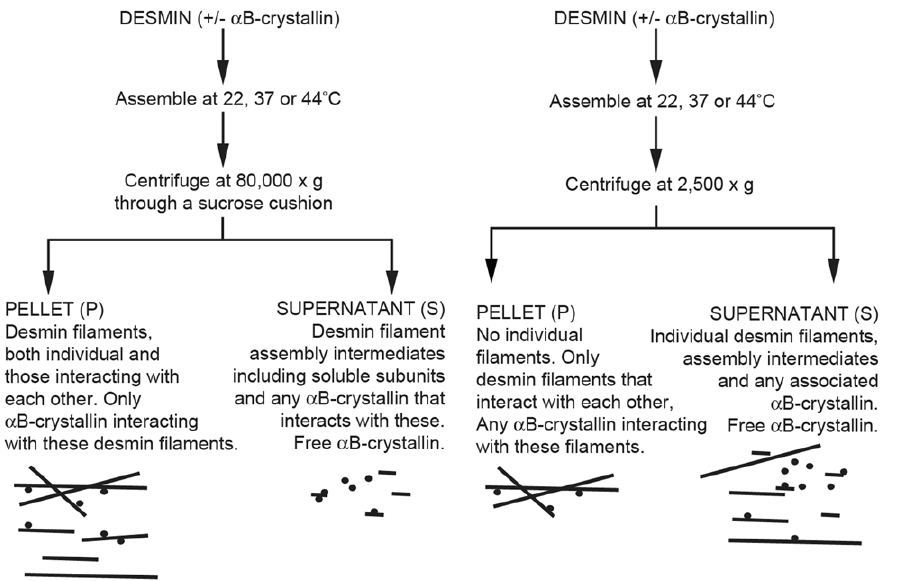
Figure 2. Desmin sedimentation assays. (LEFT) Schematic of the 80,000 g (high-speed) sedimentation assay [8,9,30]. Desmin was assembled at 22, 37, or 44 u C and centrifuged at 80,000 g. The pellet (P) will contain desmin filaments and any aggregates formed as a result of filament-filament interactions. Any a B-crystallin that associates with these filaments or their aggregates will also be cosedimented. The supernatant (S) will contain soluble a B-crystallin and also any assembly intermediates or unassembled desmin. Therefore this assay measures filament assembly and a B-crystallin binding to assembled filaments. (RIGHT) Schematic of the 2,500 g (low speed) centrifugation assay. Individual desmin filaments will not be sedimented by these sedimentation conditions, neither will a B-crystallin. Only when the assembled desmin filaments self-associate into filament aggregates, will these sediment. Therefore this assay measures filament-filament interaction. If a B-crystallin binds to these aggregates, then it too will be cosedimented. Unlike the high-speed assay, it is the aggregate-associated a B-crystallin which will sediment into the pellet fraction (P) rather than the individual filaments and their associated a B-crystallin. The supernatant (S) will contain the free desmin filaments, their associated a B crystallin, desmin assembly intermediates and the unassociated a B-crystallin